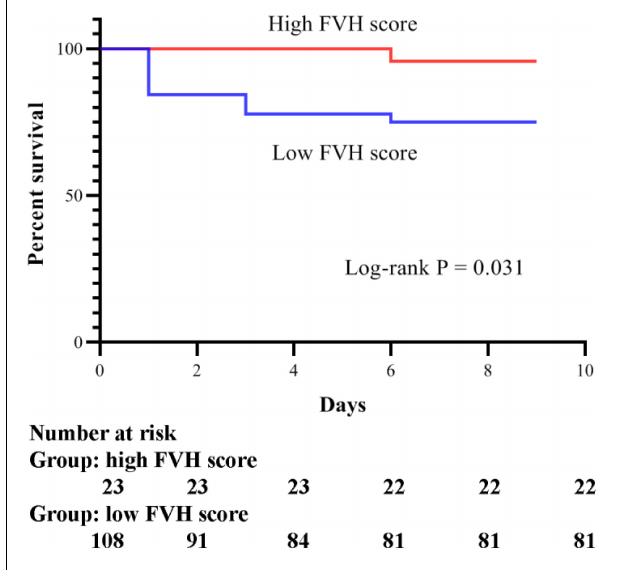
FIGURE 1 | Kaplan-Meier survival curves for acute stroke